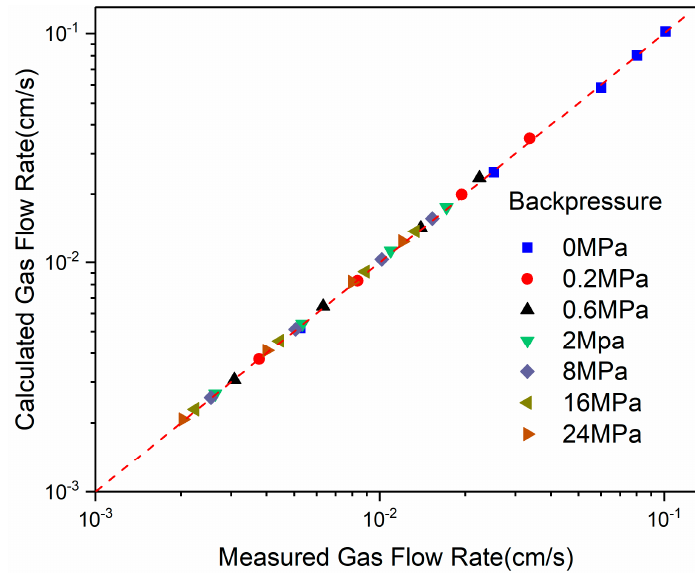
Figure 8. Measured flowrate versus theoretical flowrate at diverse backpressures for core Z1.